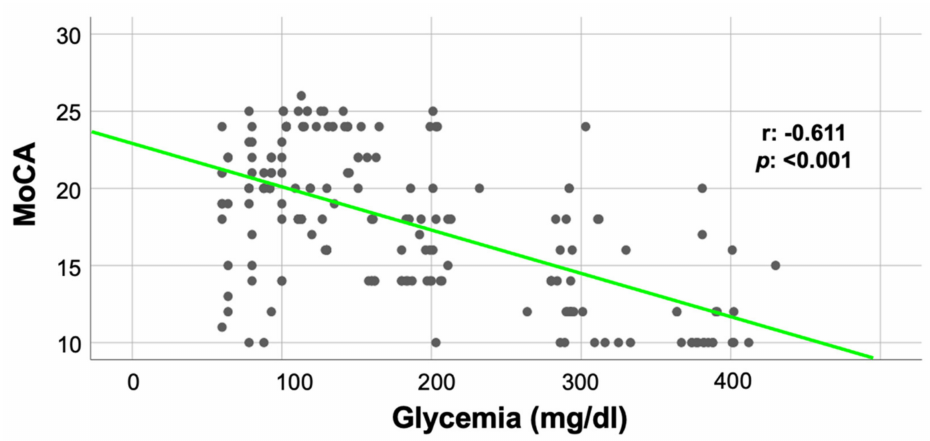
Figure 2. Correlation between MoCA score and glycemia.